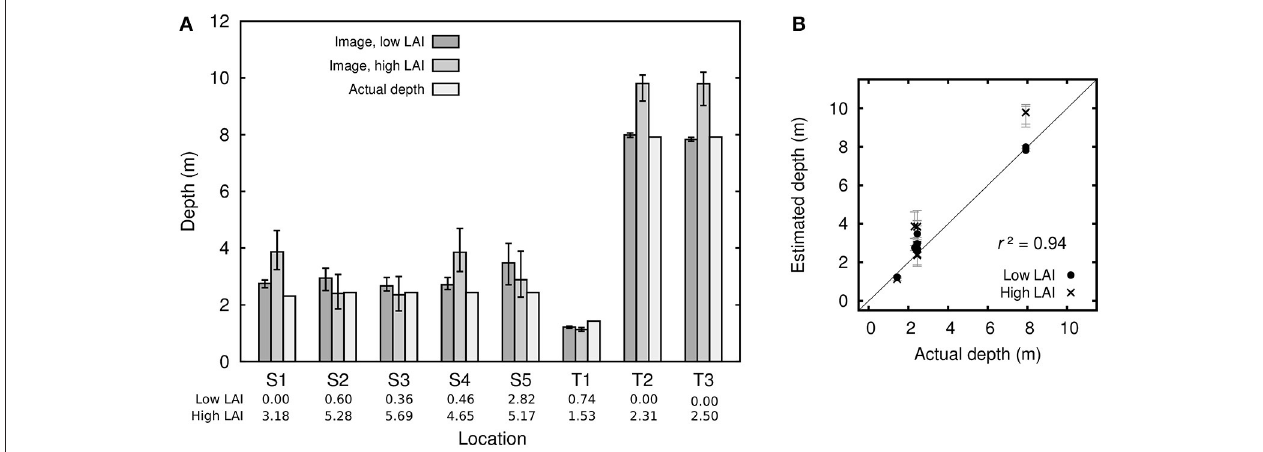
FIGURE 13 | (A) Depth estimates for the five sites dominated by Syringodium (S1-S5) and the three by Thalassia (T1-T3). Low LAI and high LAI are each averages over 5 pixels within an approximate 20m radius of the location center, selected as examples of low and high LAI pixels. Error bars are the mean of the upper and lower 90% confidence intervals from the uncertainty propagation. (B) Scatterplot of actual depth against estimated depths over low and high LAI locations, i.e. the same data as (A)